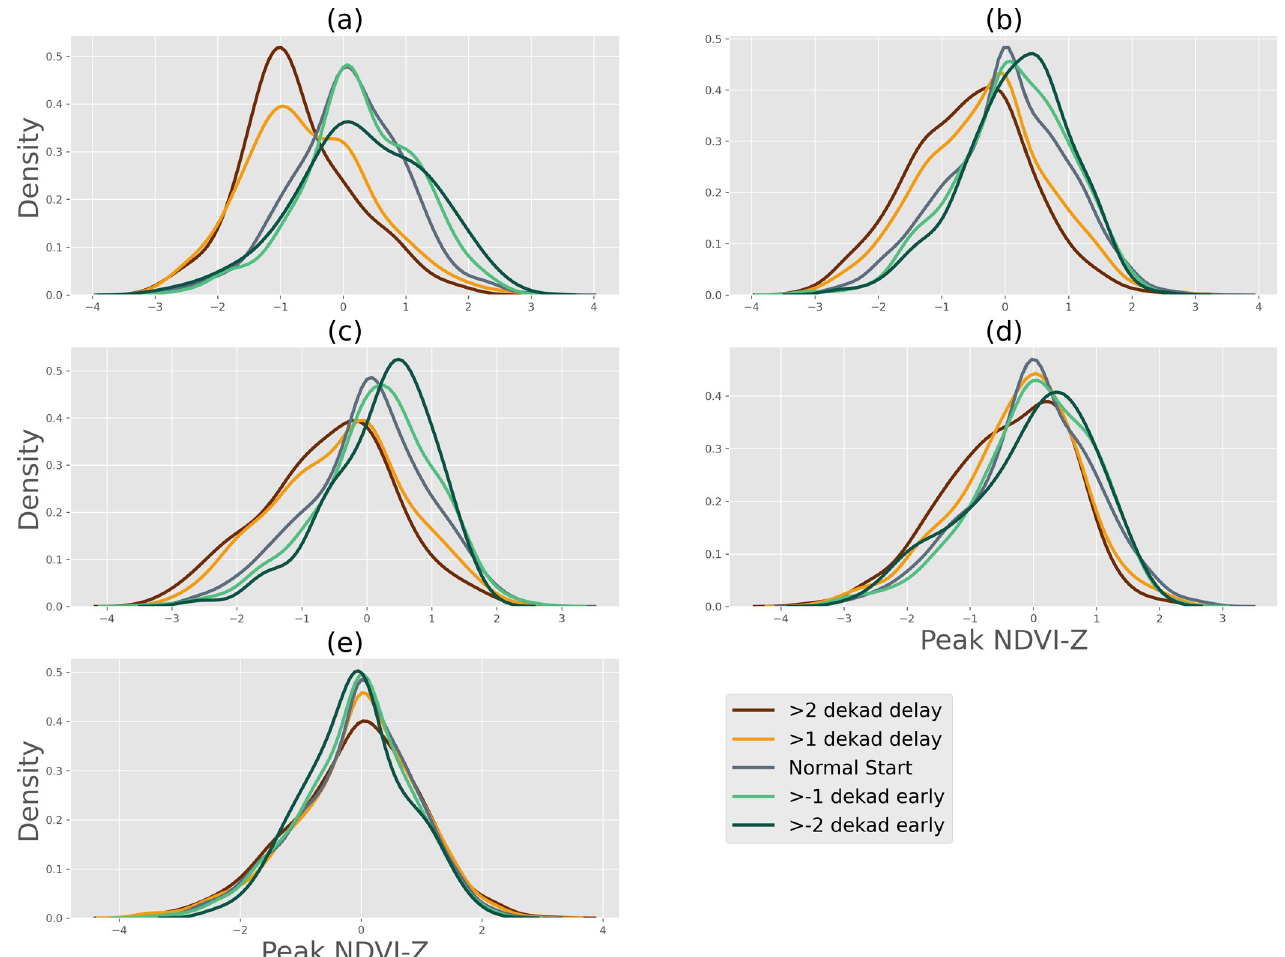
Fig 5. Difference in probability distributions of NDVI Z when onset date was delayed versus normal versus early, for the AU2s in Sub-Saharan Africa with AFI risk (a) level 5, (b) level 4 (c) level 3, (d) level 2, (e) level 1.